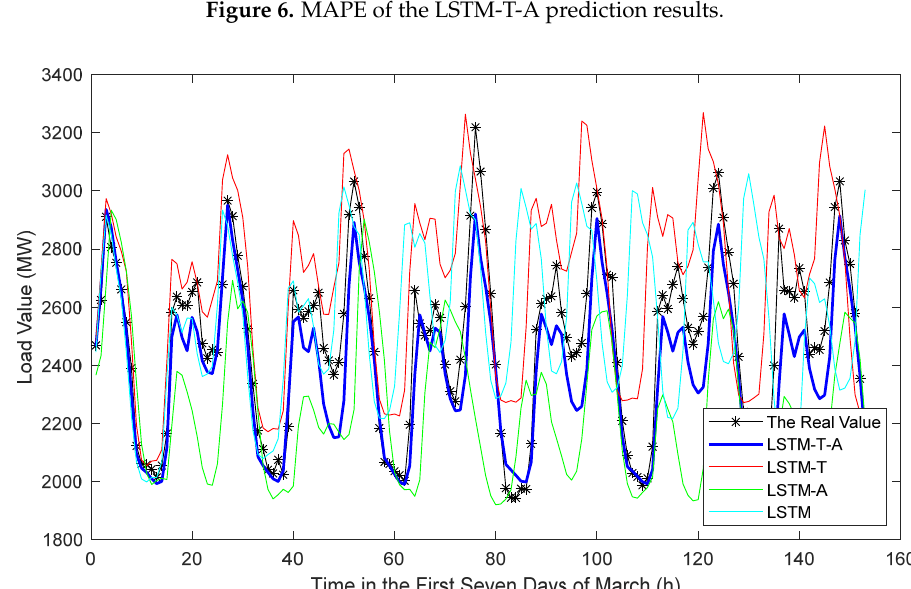
Figure 7. Forecast results of electric heating load. The MAPE (Mean Absolute Percentage Error), MAE (Mean Absolute Error), and RMSE (Root Mean Square Error) of the above four models are shown in Table 4. In addition to comparing the improved part of LSTM, the errors of SVM and ANN are also com- pared. Table 4. Prediction performance comparison of different neural network algorithms.